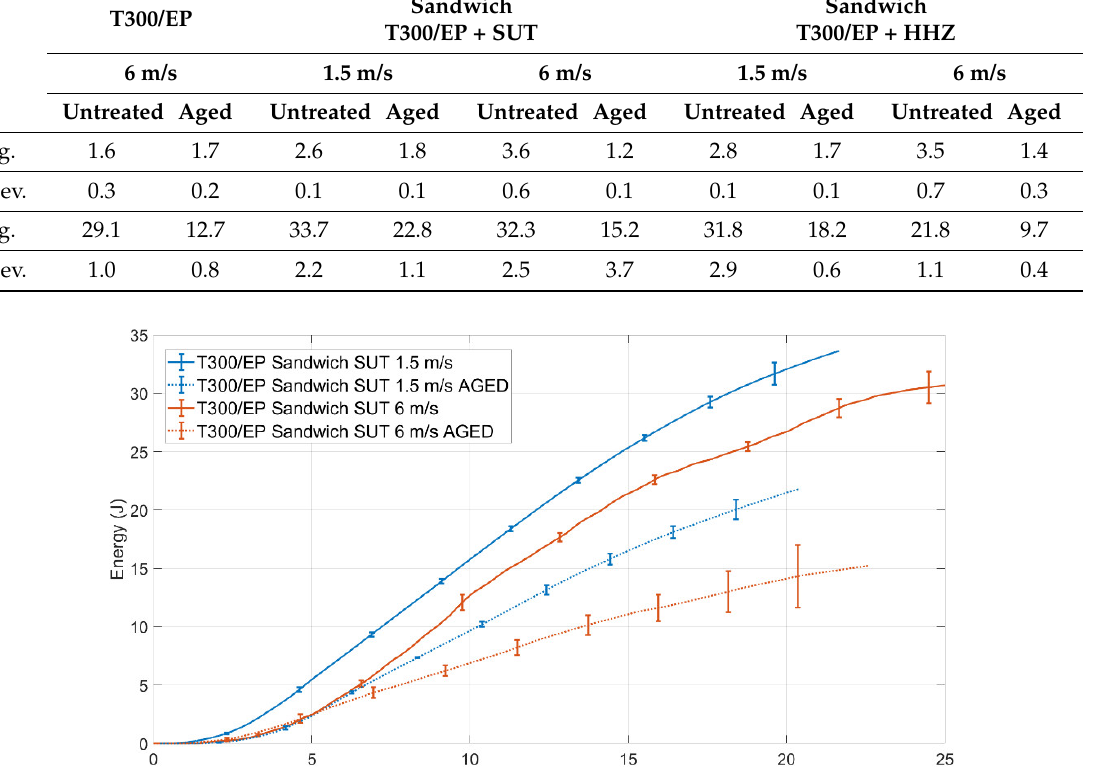
Figure 5. Energy-displacement mean curves for untreated or aged specimens of sandwich with Kraibon.